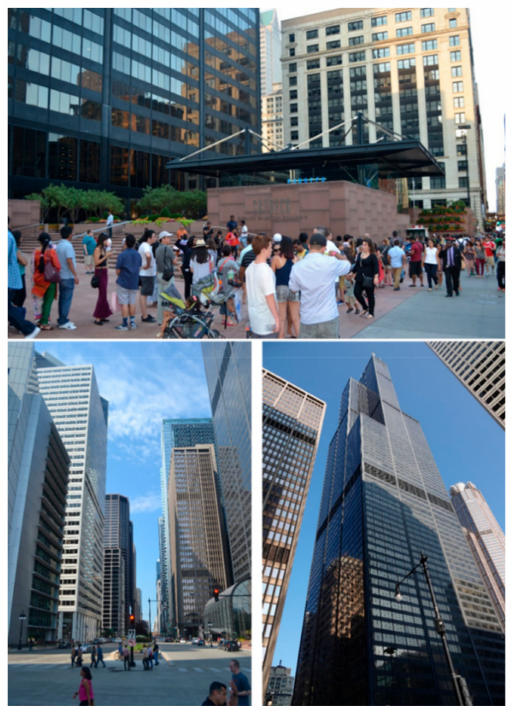
Figure 14. “Giant” skyscrapers line up alongside the Wacker Drive corridor. Among these skyscrapers is the Willis Tower, Chicago’s tallest building. Interestingly, plazas around the building’s base enliven the area. People entertain and wait in line to visit the observation deck, “Skydeck”, located on the 103rd